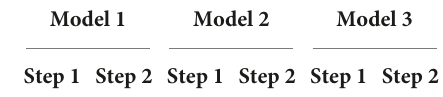
TABLE 4 Multiple regression analyses of leader-member exchange on humor in